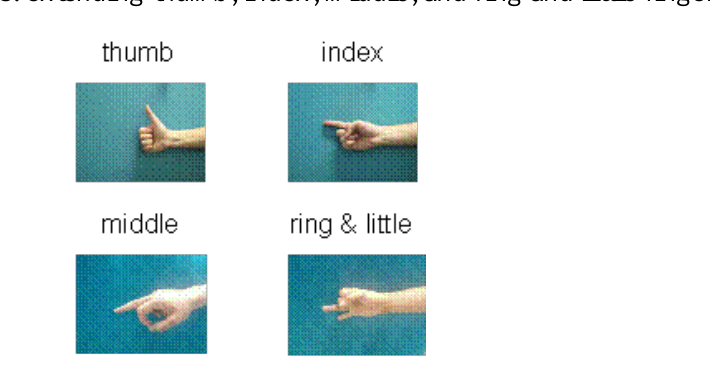
Figure 4. Four gestures: extending thumb, index, middle, and ring and little fingers.